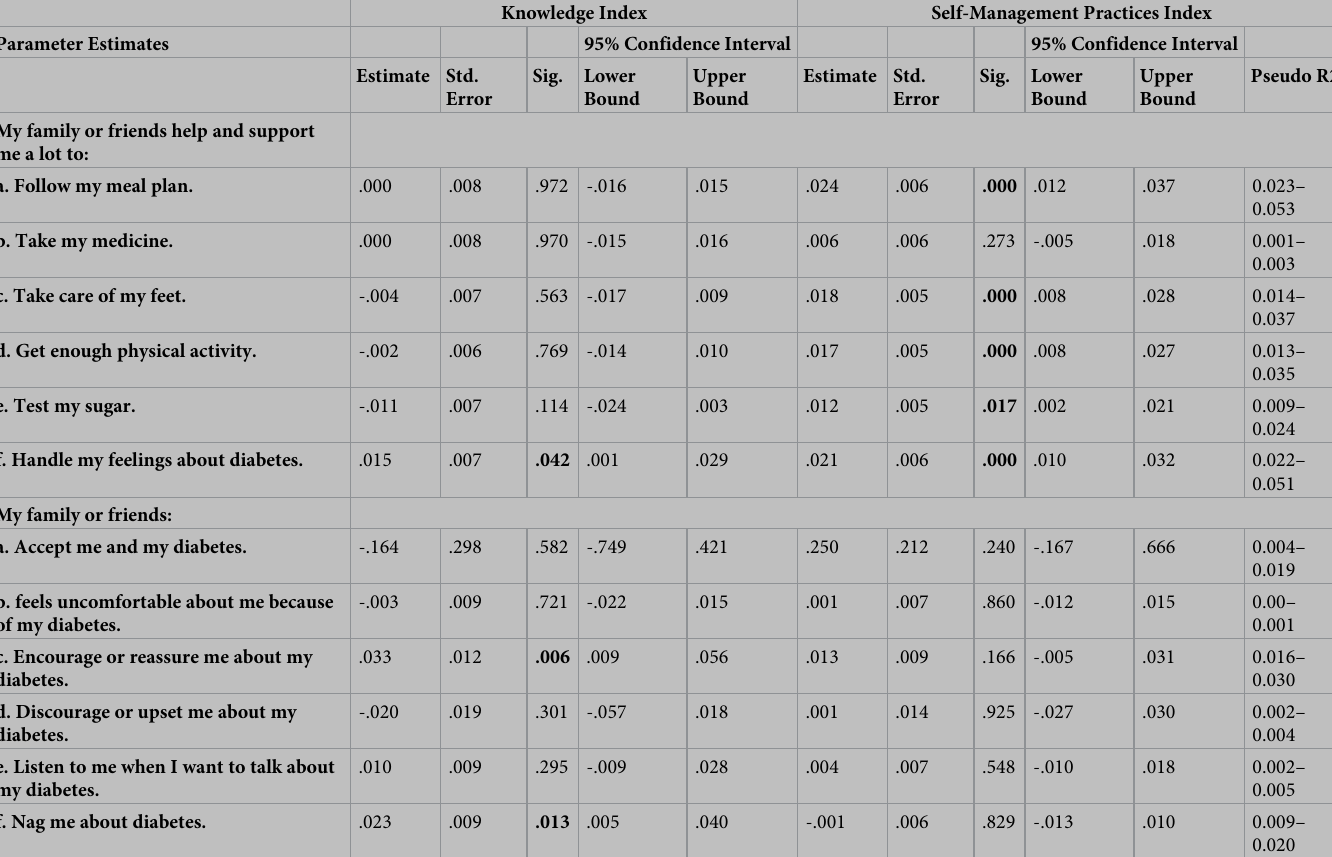
Table 5. The ordinal logistic regression models of knowledge, self-management practice with the components of social support